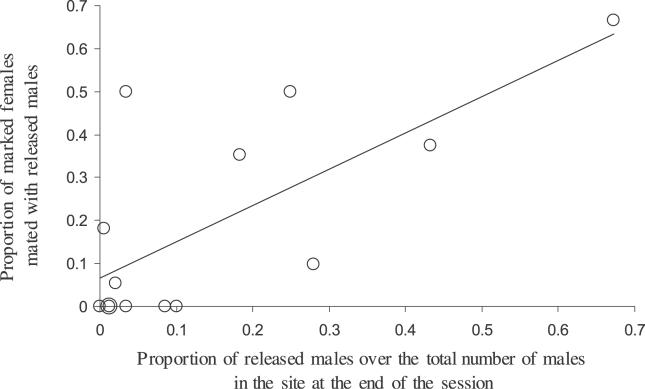
Frequency of Crossing among Resident Moths as a Function of the Local Abundance of Resident MalesExperiment 1. Correlation between the proportion of marked among spermatophores dissected from marked
O. nubilalis females recaptured during a given session and the proportion of marked males among the total number of males captured during recapture during the same session (
r
S = 0.622,
p < 0.05,
n = 14).